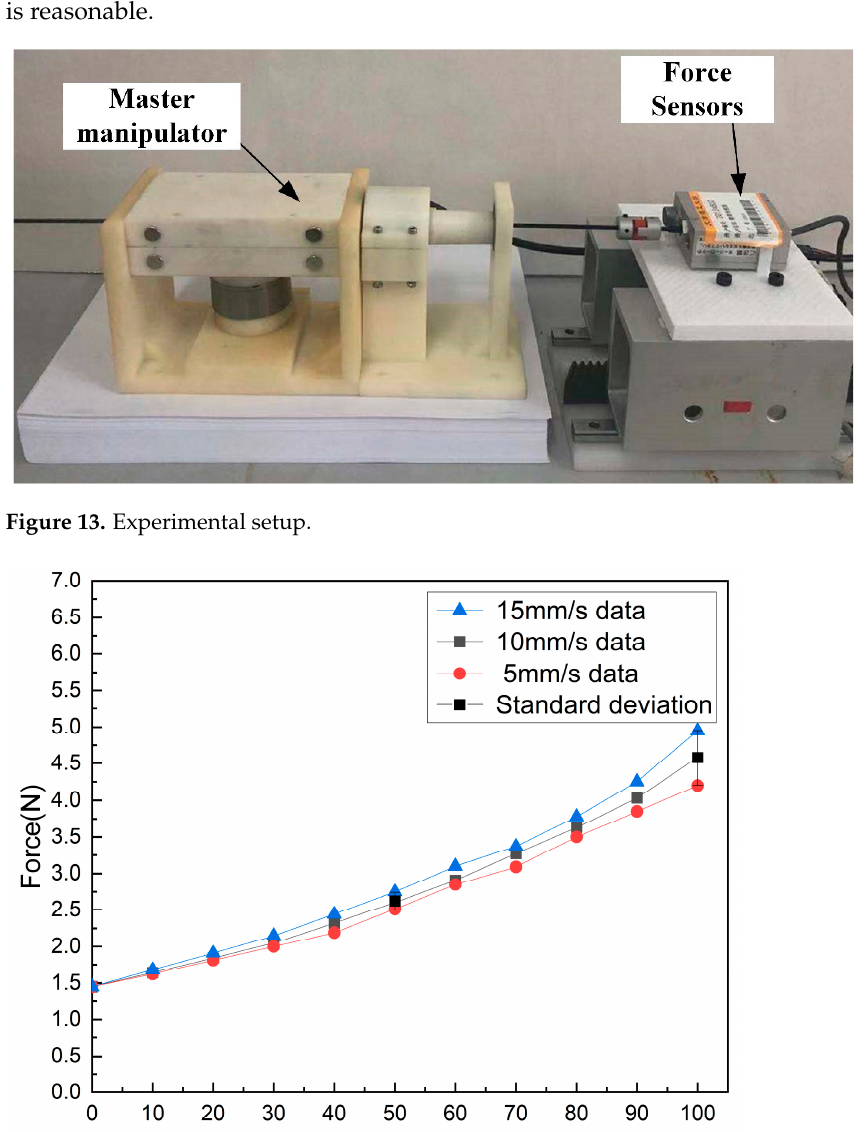
Figure 14. Validation experimental data from the master manipulator.